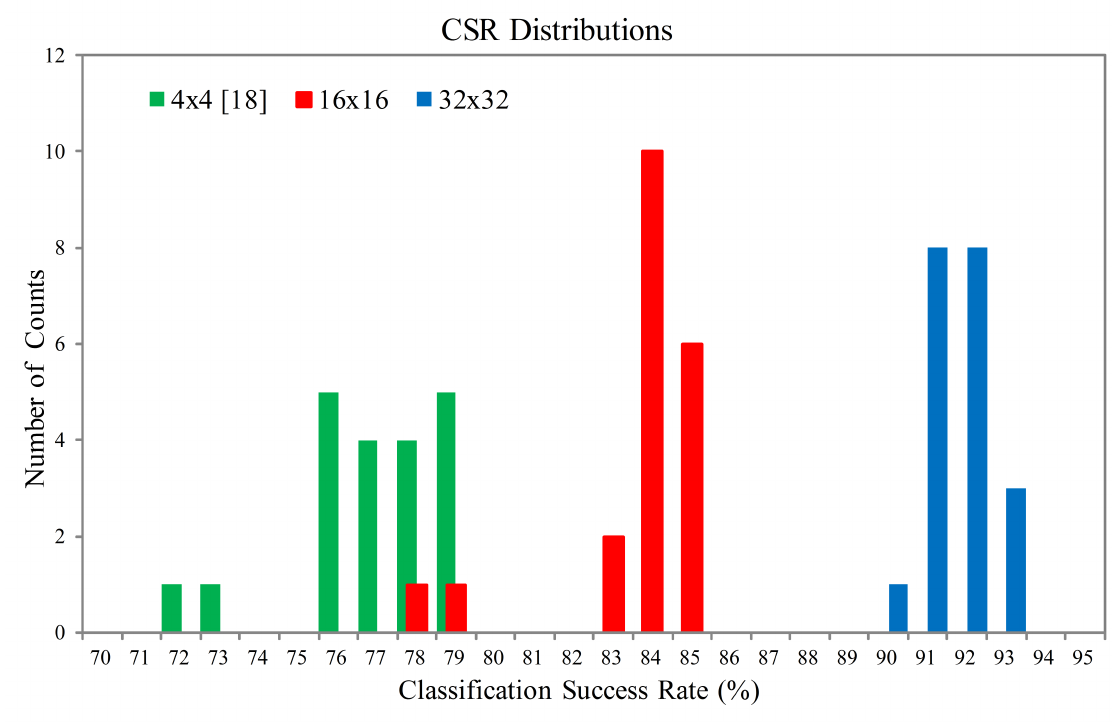
Figure 18. The CSR distributions of the proposed architecture for the texture set shown in Figure 20.